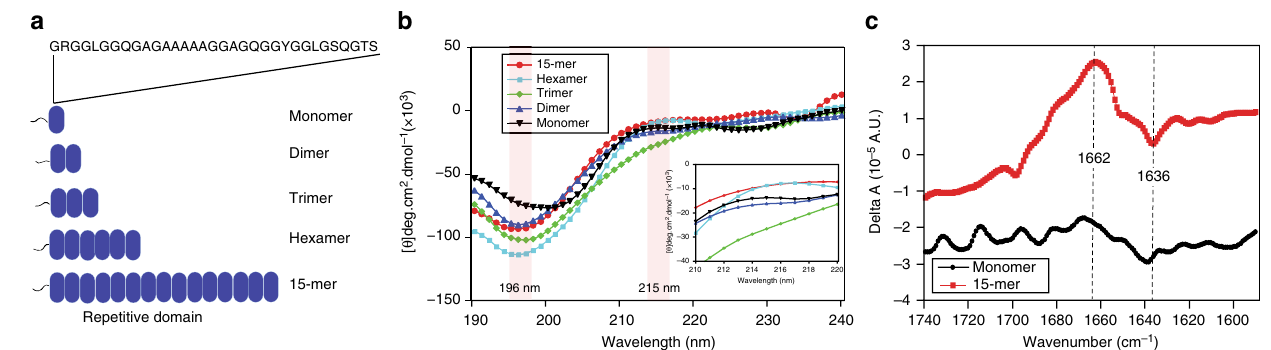
Fig. 1 Repetitive domains (Hexamer and 15-mer) contain PPII helix conformation. a Repetitive domain of spidroin (i.e., monomer, dimer, trimer, hexamer, and 15-mer) used in this study. The repeated amino acid sequence is indicated. b CD spectra of the different repeat constructs at 10 °C. The monomer (black) exhibited a minimum at ~200 nm; whereas, the dimer (blue), trimer (green), hexamer (cyan), and 15-mer (red) displayed minima at ~196 nm (indicated in shaded region). The hexamer and 15-mer demonstrated slight maxima at ~215 nm (indicated in the shaded region and insert). The CD data are presented as smoothed averaged of 10 measurements ( c ) VCD spectra of the 15-mer and monomer at 25 °C and pH 7 in D 2 O. The 15-mer showed a distinctive maximum at 1662 cm − 1 and minimum at 1636 cm − 1 , which is typical of the PPII helix population 18,26 . In contrast, the overall delta absorbance of the monomer was signi fi cantly lower than that of the 15-mer, suggesting a higher proportion of the random